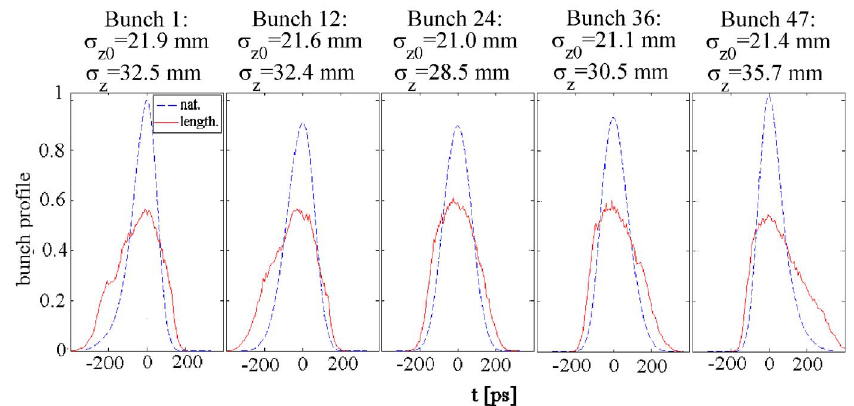
FIG. 10. (Color) Natural and lengthened profiles of the bunches along the train with a